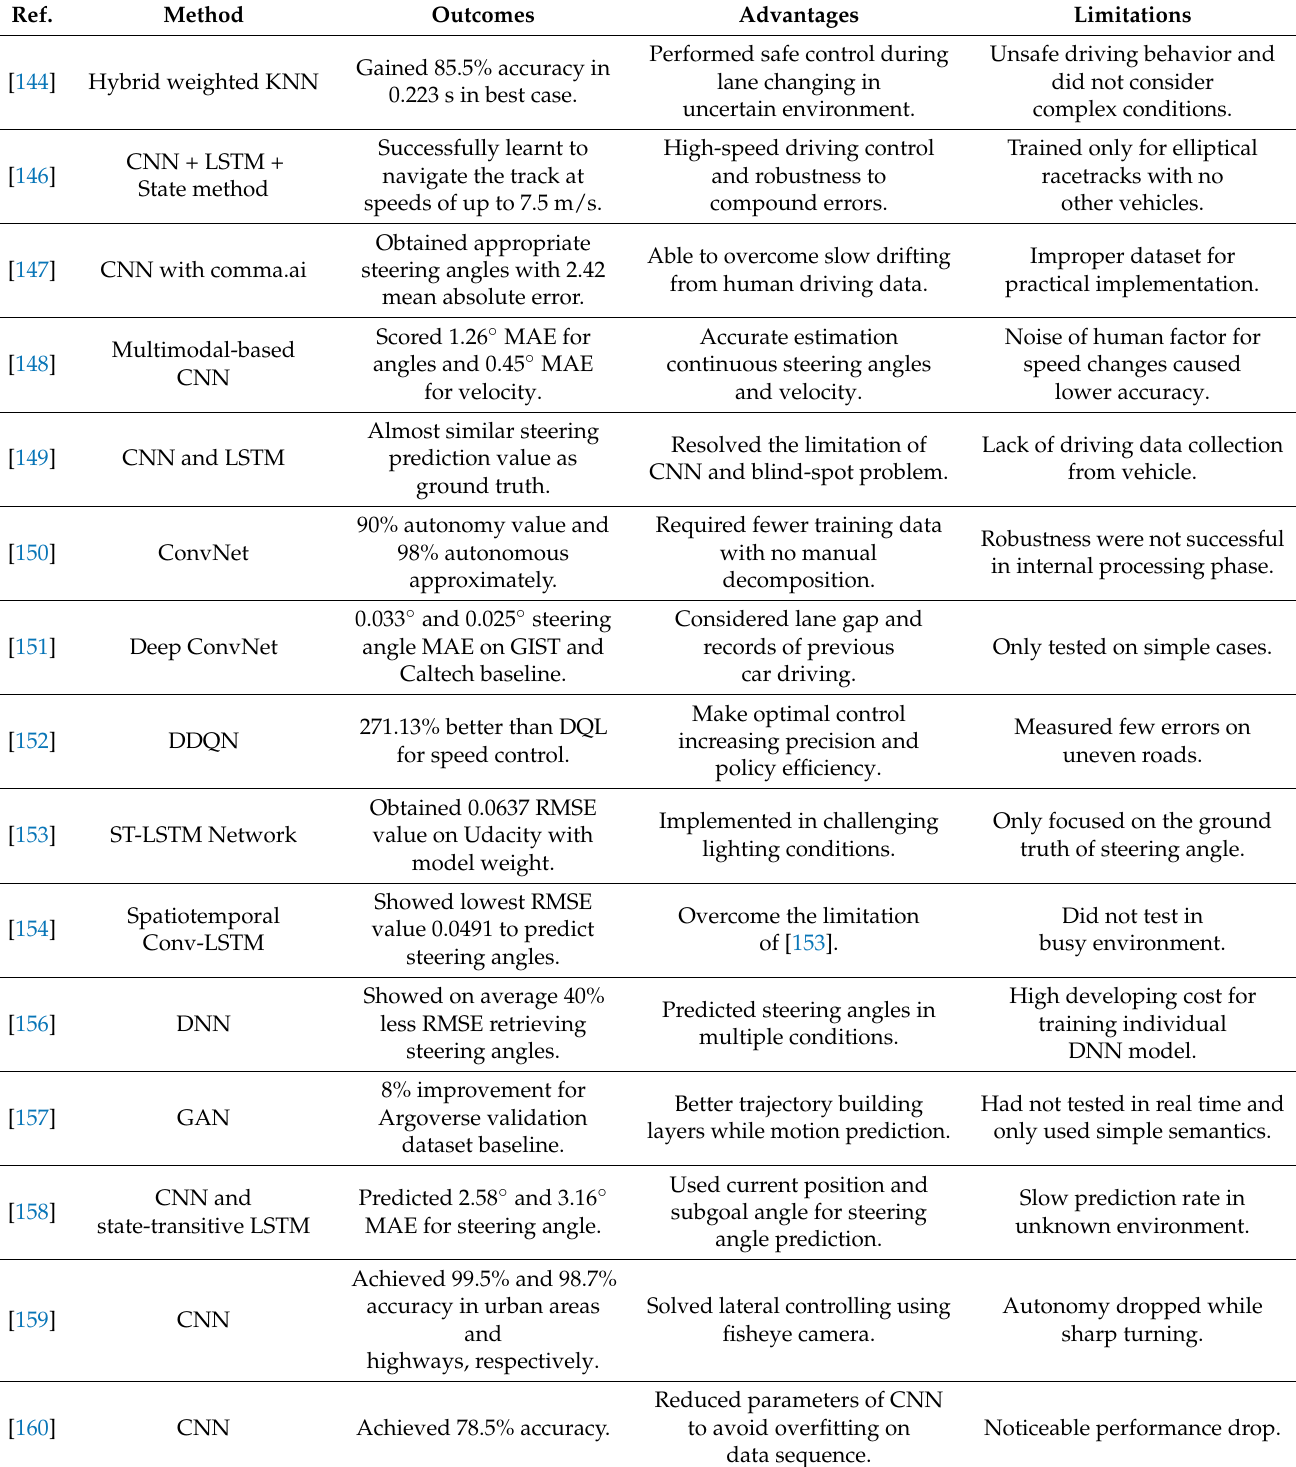
Table 11. Summary of multiple deep learning methods for end-to-end controlling and